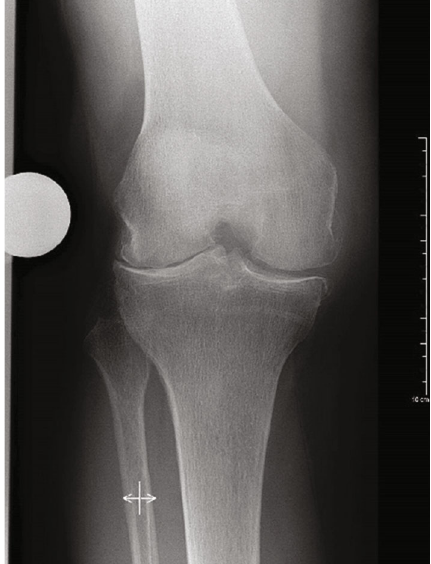
Figure 2: Preoperative radiographs showing the anteroposterior view of the right knee.